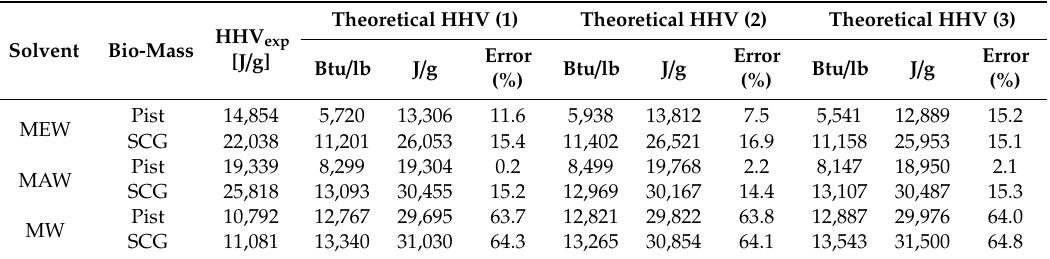
Table 4. Experimental and theoretical high heating value (HHV) with respective errors to the experimental values.